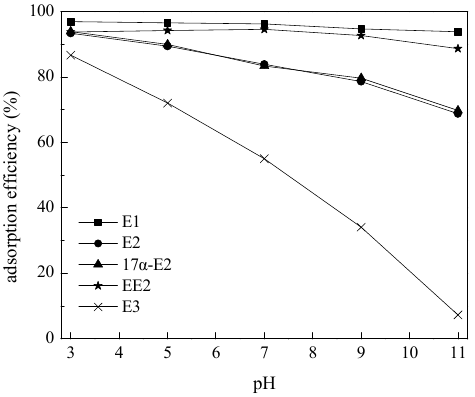
Figure 6. Effect of pH on MGO’s adsorption of estrogens (MGO = 0.05 g, T = 308 K, t = 30 min, and estrogens’ concentrations = 200 μ g/L).